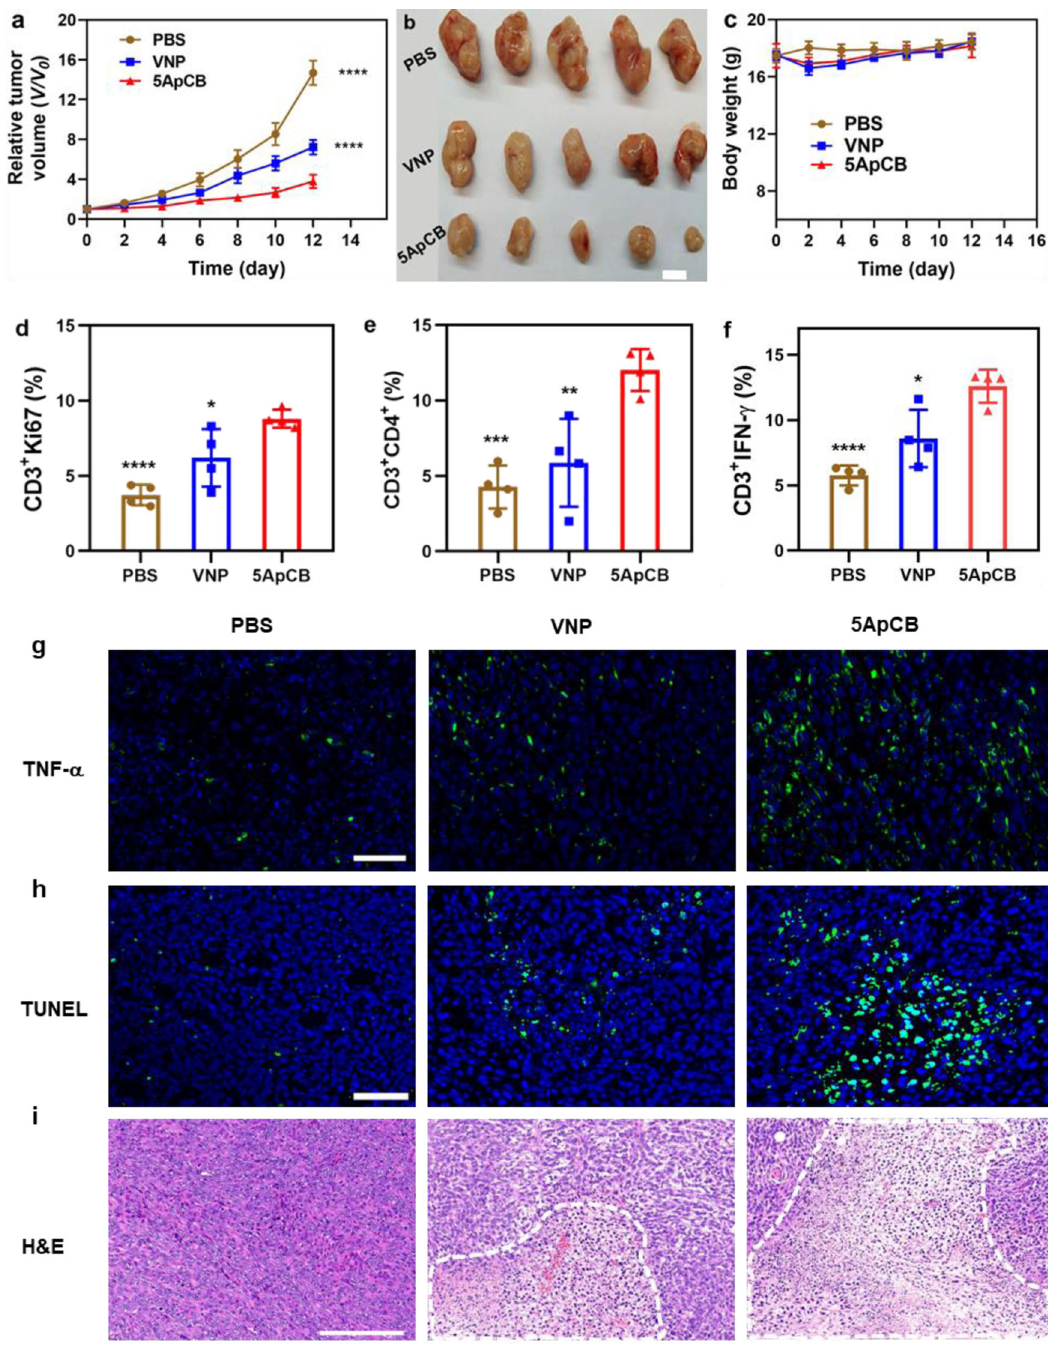
Fig. 5 In vivo therapeutic ef fi cacy of ApCB. a Relative tumor growth after different treatments ( n = 5). Data are presented as mean values± SD. Signi fi cance was assessed using Student ’ s t test (two-tailed), giving p values: 0.000005 for 5ApCB vs PBS; 0.00002 for 5ApCB vs VNP. b Representative photographs of the tumor tissues harvested from mice at the end of the treatment. Scale bar: 1 cm. c Variation of bodyweight during each treatment ( n = 5). Data are presented as mean values ± SD. Percentage of d Ki67 (gated on CD3 + cells) inside the tumors after treatment ( n = 4). Data are presented as mean values ± SD. Signi fi cance was assessed using Student ’ s t test (two-tailed), giving p values: 0.00003 for 5ApCB vs PBS; 0.0411 for 5ApCB vs VNP. e Flow cytometric analysis of the population of CD4 + T cells (gated on CD3 + cells) within the tumors after treatment ( n = 4). Data are presented as mean values ± SD. Signi fi cance was assessed using Student ’ s t test (two-tailed), giving p values: 0.0002 for 5ApCB vs PBS; 0.0088 for 5ApCB vs VNP. Percentage of f IFN- γ (gated on CD3 + cells) inside the tumors after treatment ( n = 4). Data are presented as mean values ± SD. Signi fi cance was assessed using Student ’ s t test (two-tailed), giving p values: 0.00009 for 5ApCB vs PBS; 0.0192 for 5ApCB vs VNP. Images of tumor tissues stained with g TNF- α (green) and h TUNEL (green). Blue indicates nuclei stained with DAPI. Images are representative of three independent biological samples. Scale bar: 50 μ m. i Typical H&E staining images of the sectioned tumors after different treatments. Necrotic areas were circled by a white dotted line. Images are representative of three independent biological samples. Scale bar: 200 μ m. * p < 0.05, ** p < 0.01, *** p < 0.001, **** p < 0.0001. Source data are provided as a Source Data fi